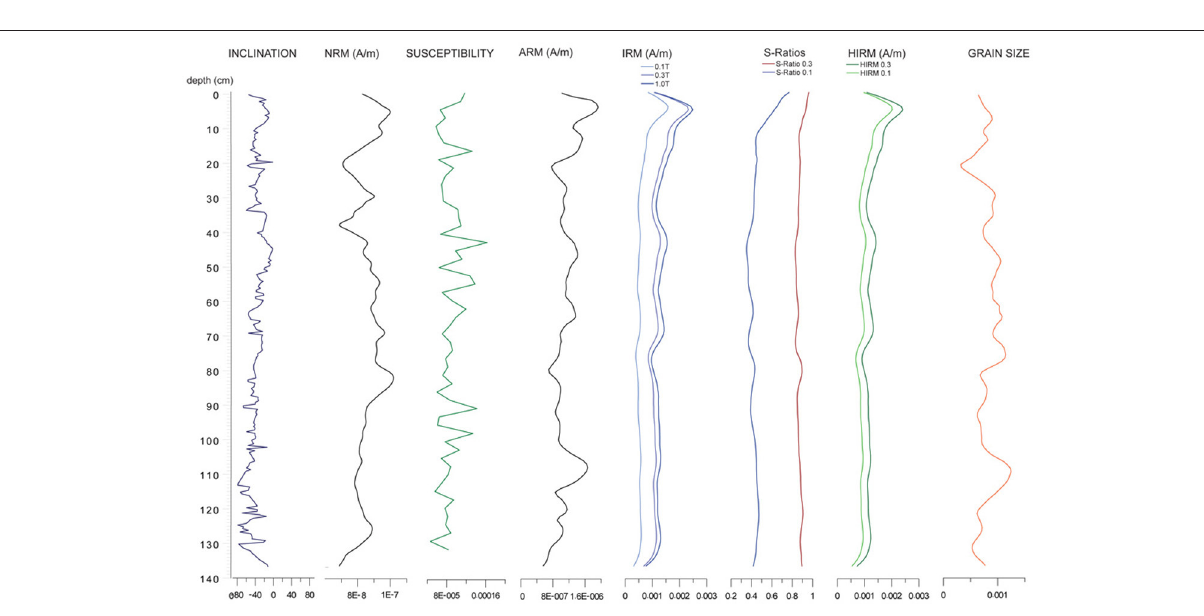
FIGURE 6 | Distribution of paleomagnetism data for core